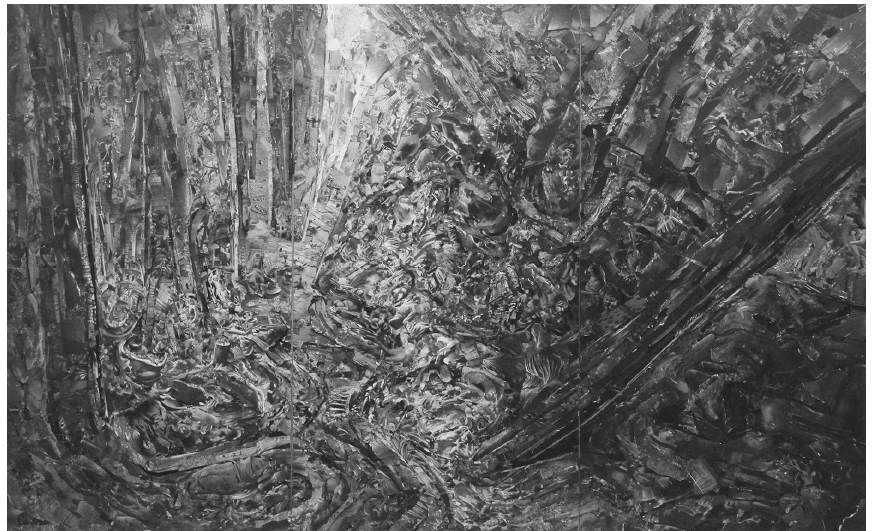
Figure 8. Sabine Hertig. Landscape 14, 2017, Analogue Collage on Canvas, 300 × 465 cm, composed of three panels,